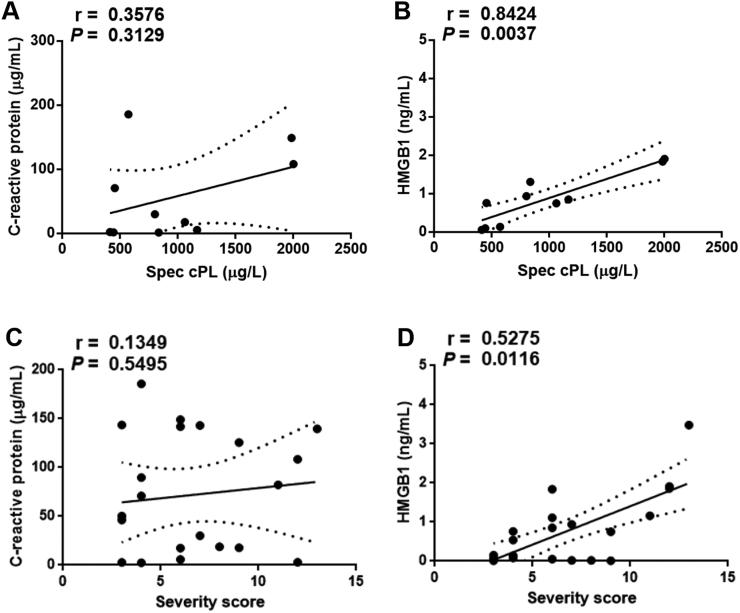
Correlations between the serum concentrations of CRP (A, C) and HMGB1 (B, D), with highly specific cPL (n = 9) and the severity score (n = 22) in AP dogs. The dotted lines indicate the 95% confidence intervals. *P < 0.05 (Spearman correlation). AP, acute pancreatitis; CRP, C-reactive protein; HMGB1, high mobility group box 1.